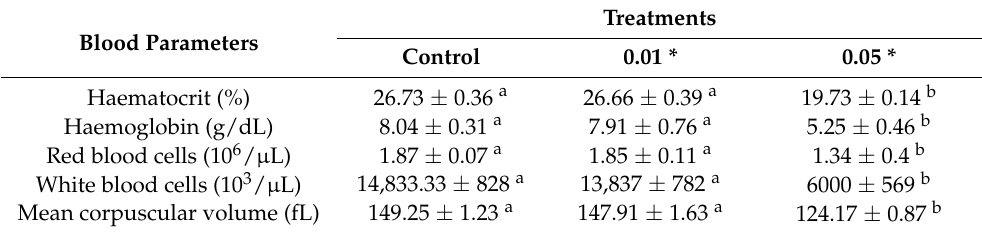
Table 4. Blood parameters of grass carp ( Ctenopharyngodon idella) after 21 days of exposure to sublethal concentrations of diazinon (DZN).